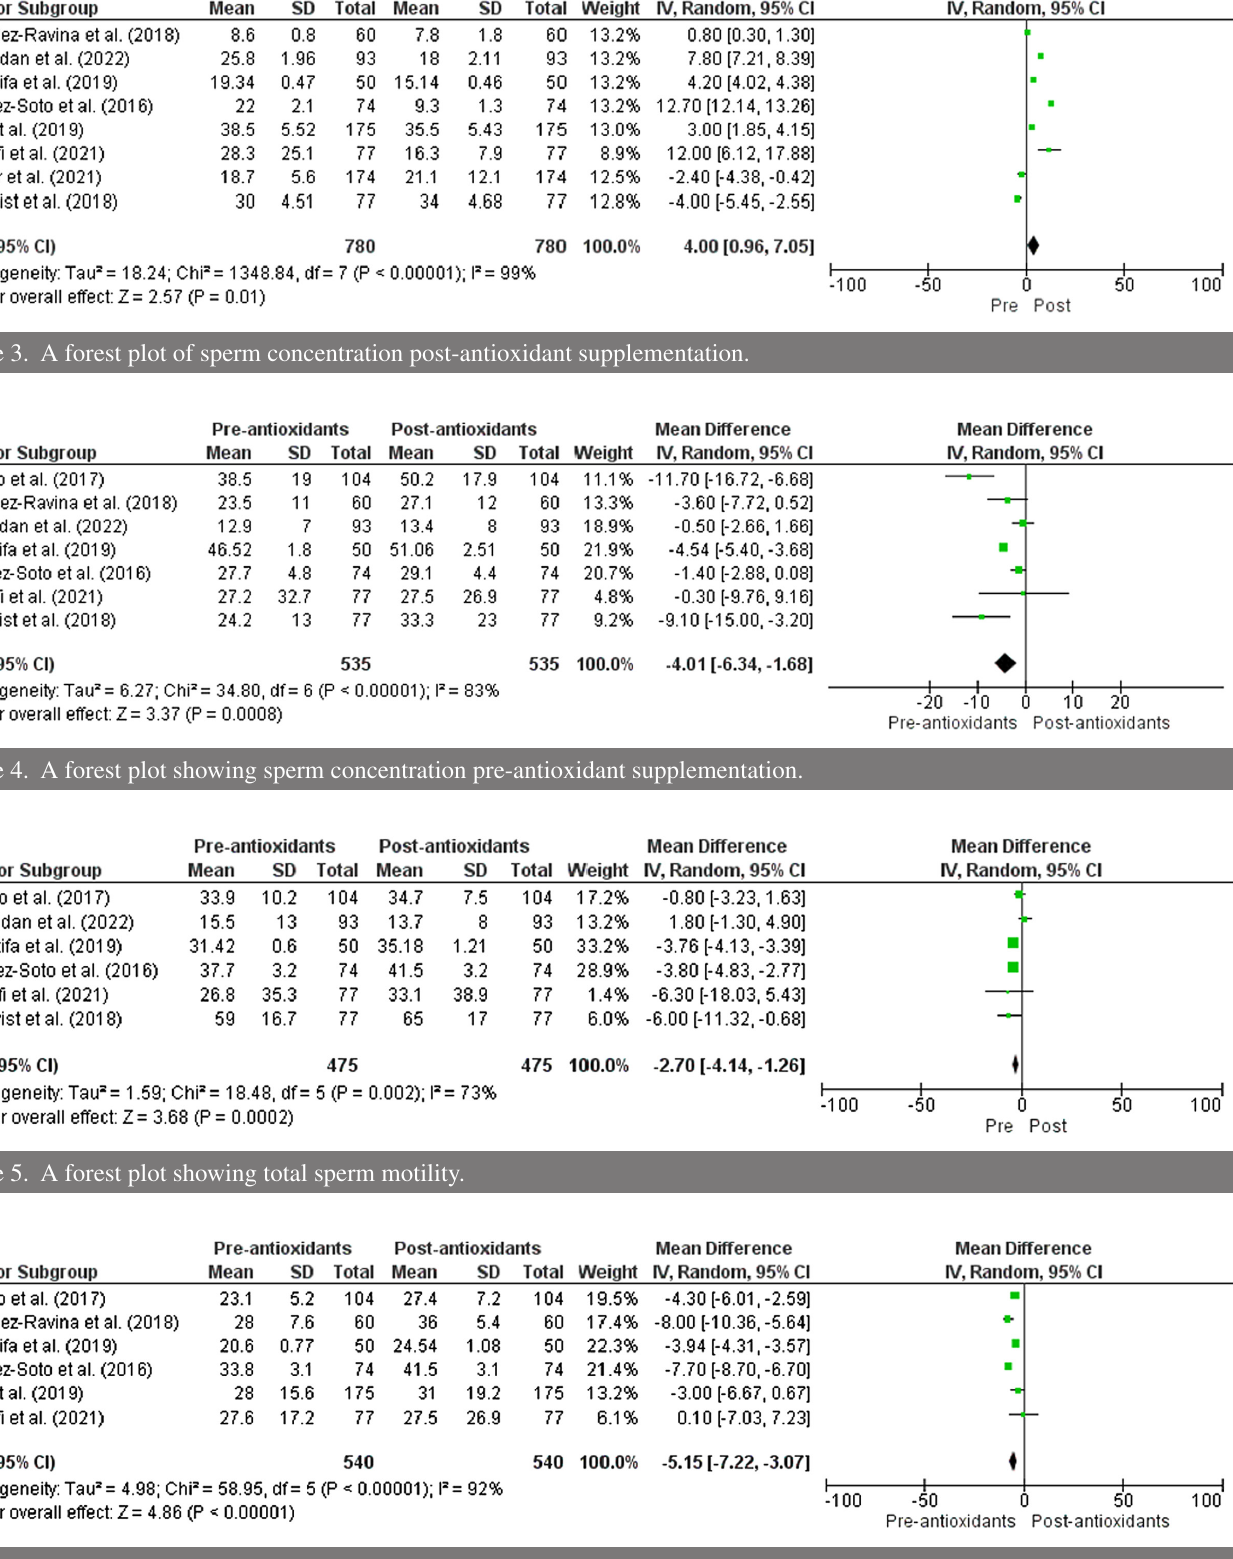
Figure 6. A forest plot showing progressive sperm